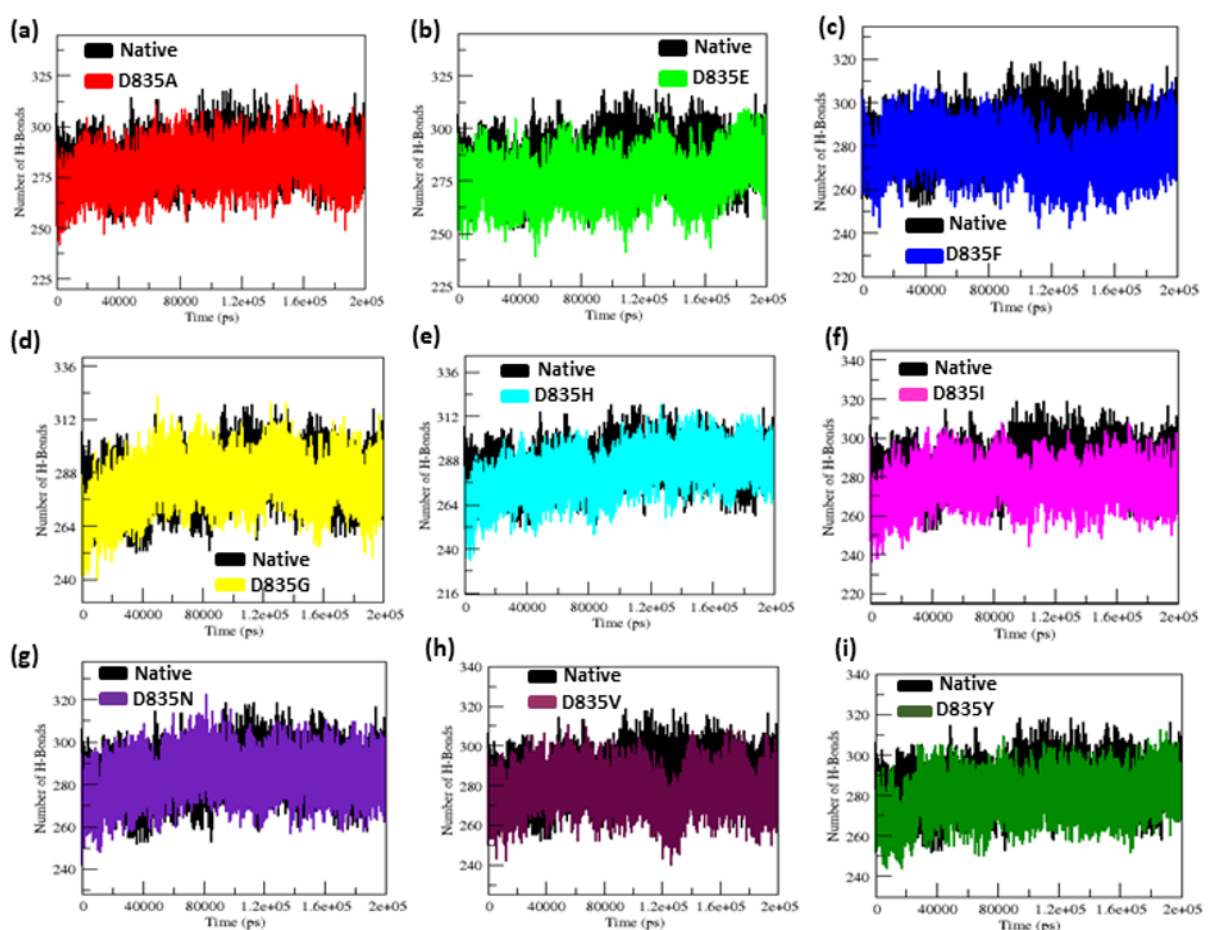
Figure 5. Intramolecular H-bond simulation data for native and mutant FLT3 protein structures for 200 ns, ( a – i ) elucidating a clear difference in H-bonds between native and mutant FLT3 structures. ( a ) Native vs. D835A; ( b ) Native vs. D835E; ( c ) Native vs. D835F; ( d ) Native vs. D835G; ( e ) Native vs. D835H; ( f ) Native vs. D835I; ( g ) Native vs. D835N; ( h ) Native vs. D835V; ( i ) Native vs. D835Y.